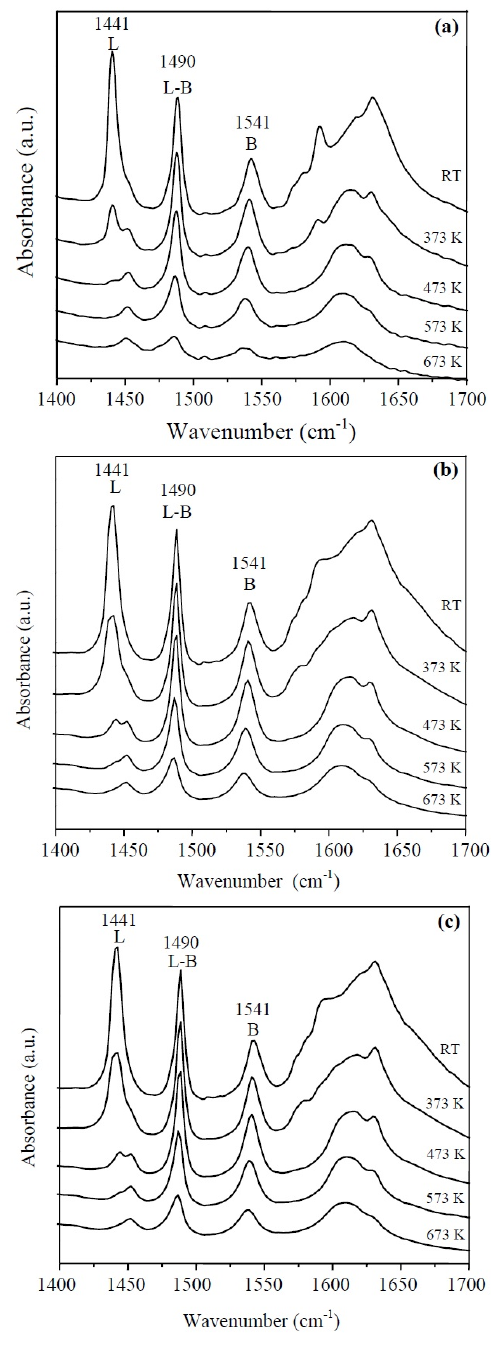
Figure 6. IR-Py spectra of ( a ) HY zeolite; ( b ) LaY and ( c ) Pd/LaY catalysts at different temperatures.